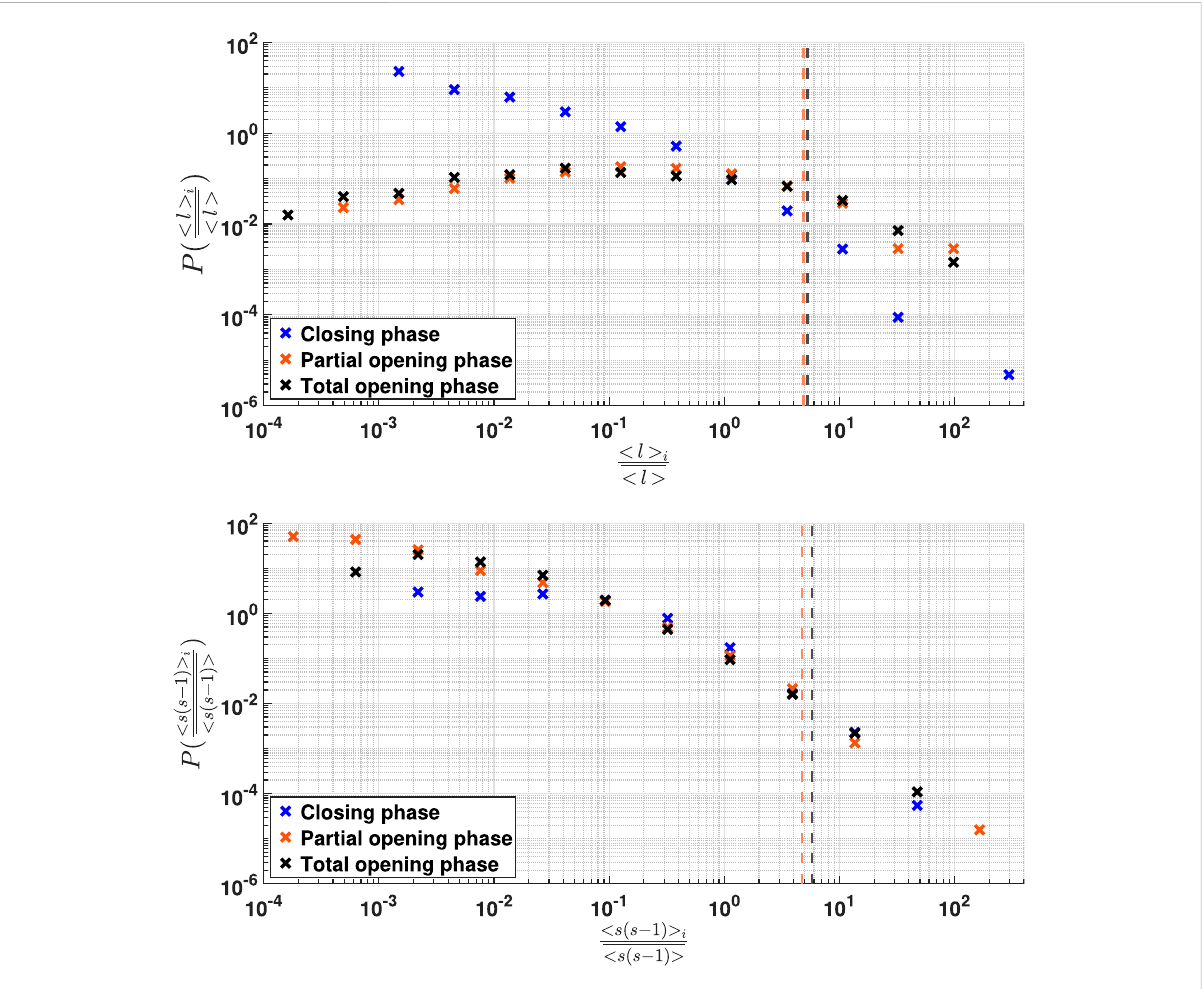
LinkdistributionamongthedifferentAPs.Theplotsshowhowtheaveragenumberofdifferentlinksperday < l > i andaveragelinks < s ( s − 1 ) > i are distributed among the different APs. Both quantities are normalized by their average over the different APs. The dashed lines correspond to the thresholdsthatgivethecriticalAPsinFigures10,11.Thereisadifferentdistributionfortheclosing periodcomparedtotheopeningphases,clarifying that groups are more stable in the closing